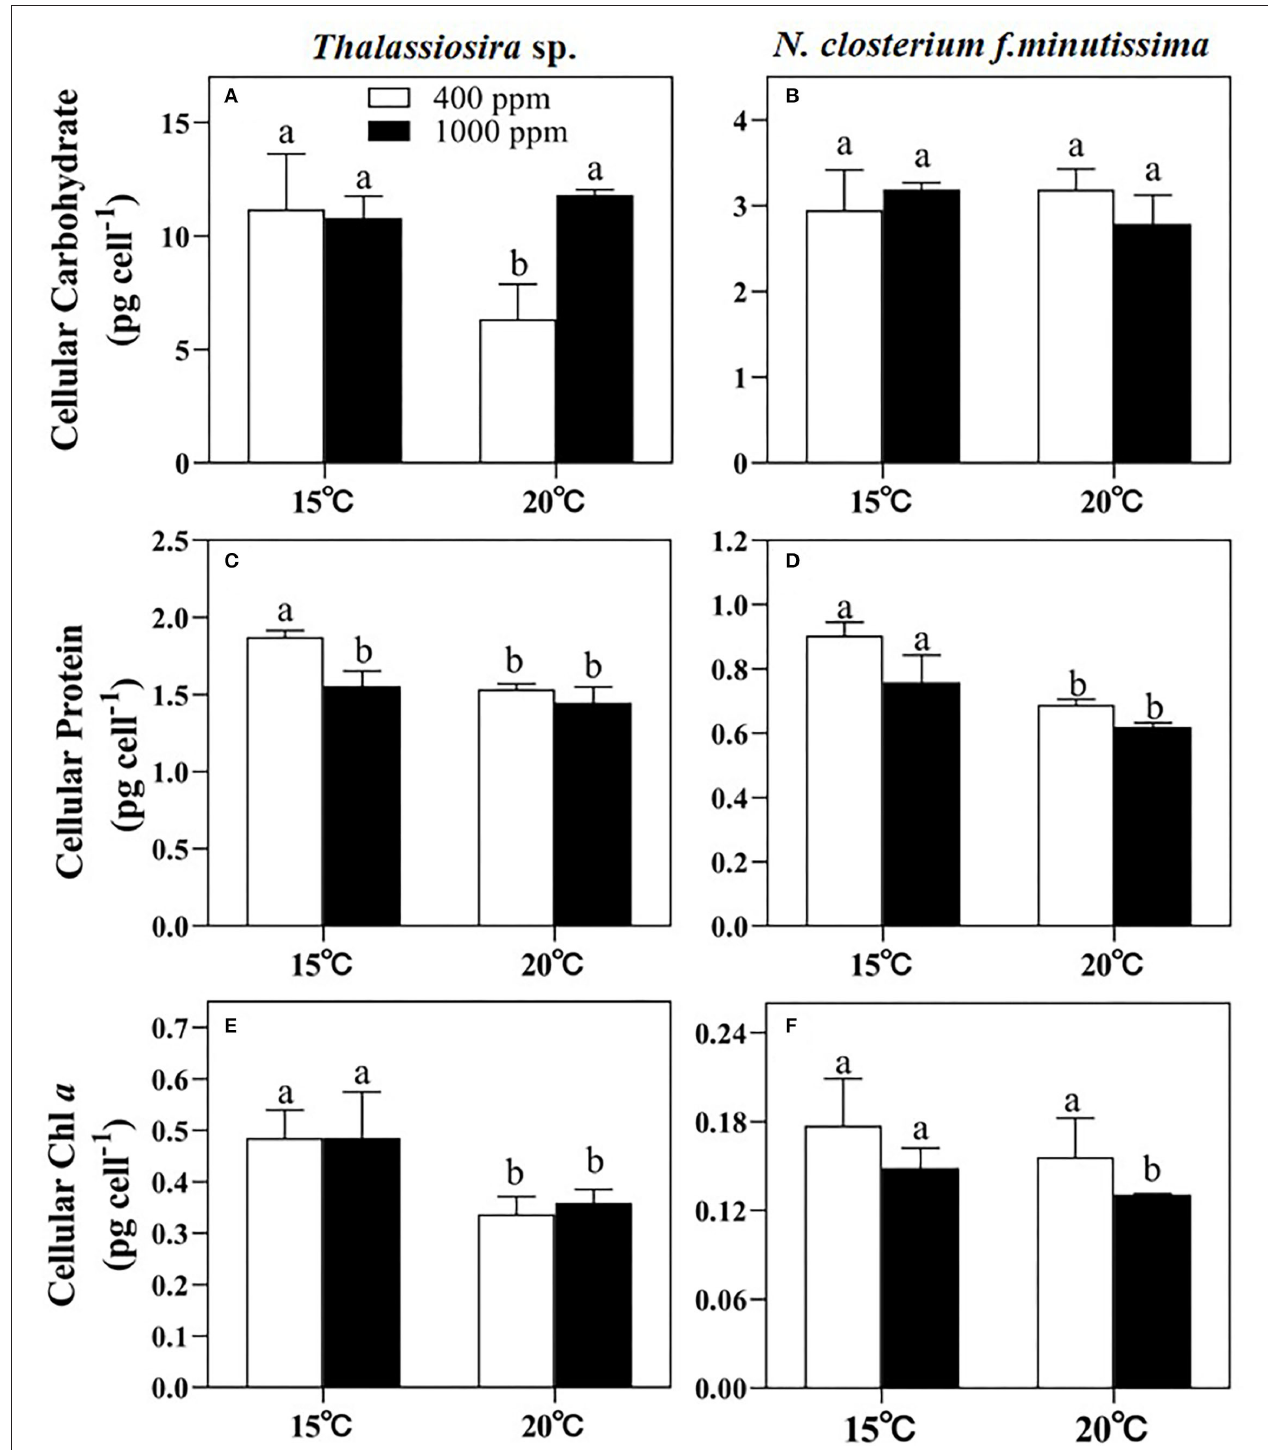
FIGURE 3 | The cellular carbohydrate, protein, and Chl a contents of Thalassiosira sp. (A,C,E) and N. closterium f.minutissima (B,D,F) under different pCO 2 and temperature conditions. The error bars represent standard deviations of triplicate samples. The letters above the bars denote the statistically significant differences.